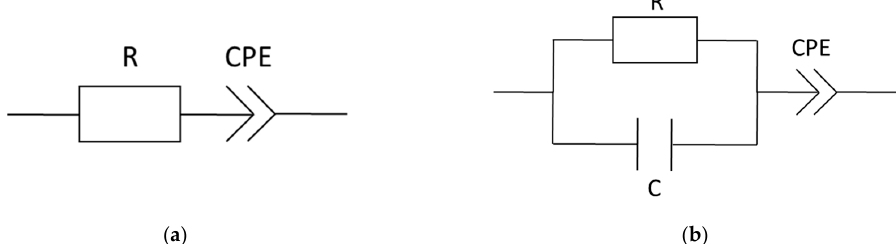
Figure 5. Equivalent circuit models, ( a ) equivalent circuit for comparison to linear extrapolation and ( b ) simple equivalent circuit summarized out of the cited literature above; R = resistance, C = capacity, and CPE = constant phase element.